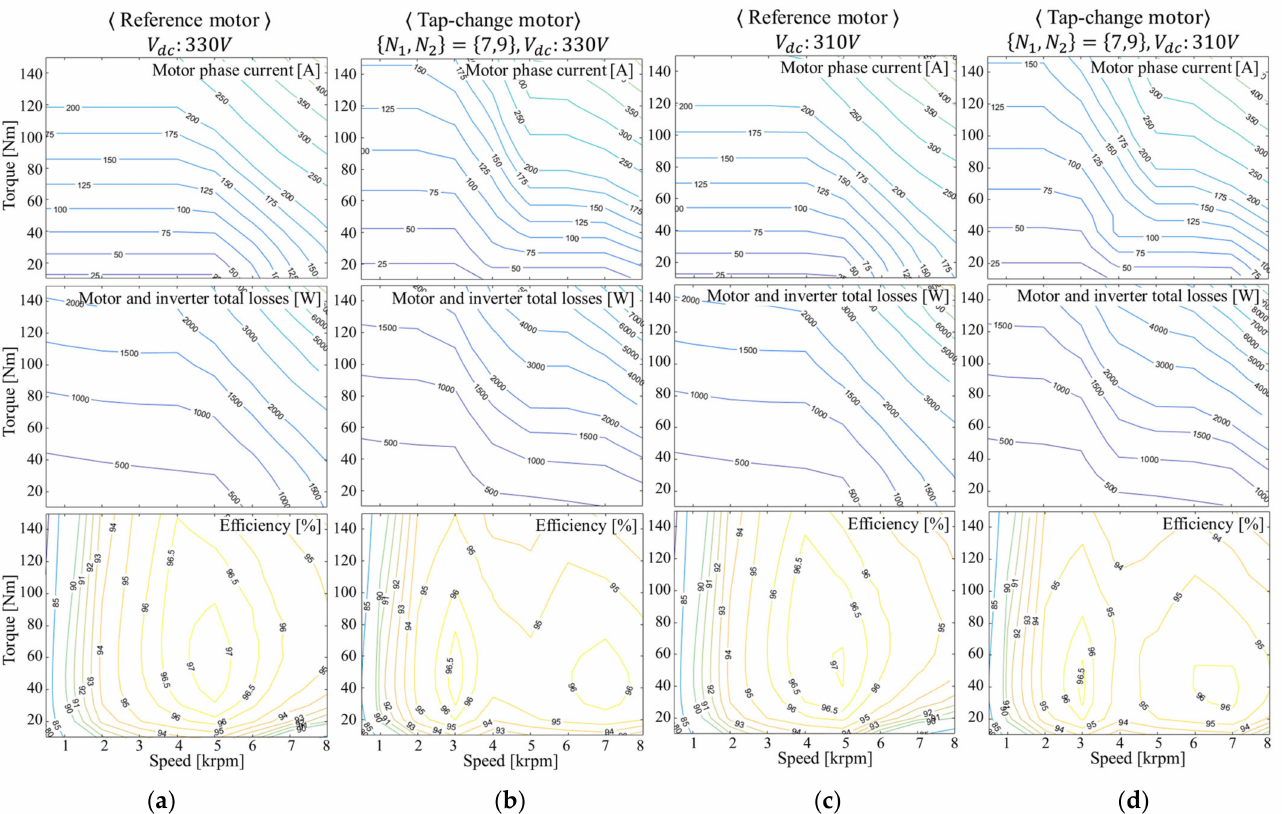
Figure 8. Motor phase current, total losses, and efficiency on speed and torque plane with the ( a ) reference motor ( V dc : 330 V), ( b ) tap-change motor ( V dc : 330 V), ( c ) reference motor ( V dc : 310 V), and ( d ) tap-change motor ( V dc : 310